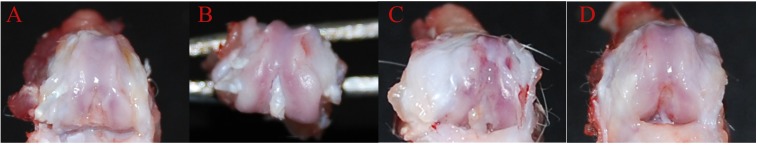
Gross morphological observation of femoral condyles at week 8 and week 12 after surgery.The control group at week 8 (A); the ADSC group at week 8 (B); the control group at week 12 (C); the ADSC group at week 12 (D). Severe erosion (C), moderate erosion (A, D) and mild lesions (B) were observed.